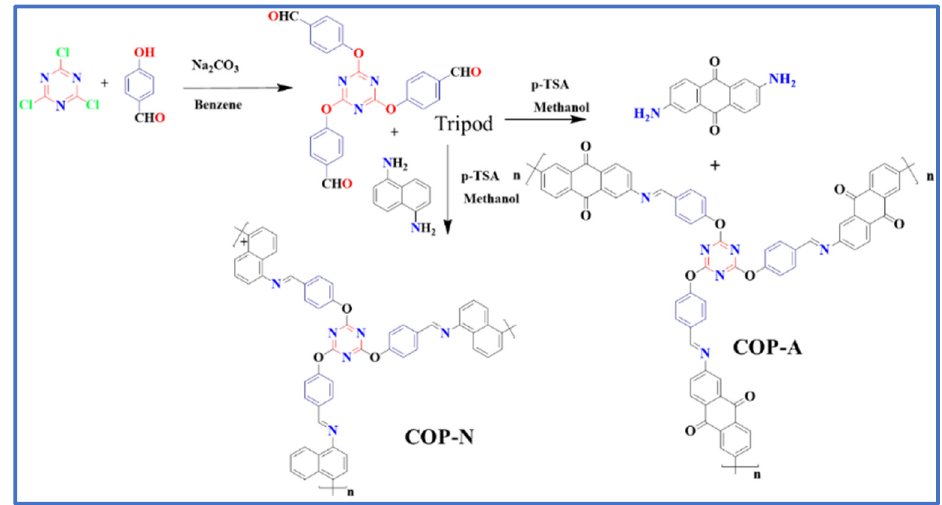
Figure 1. Synthesis route of covalent organic polymer of COP-N and COP-A.